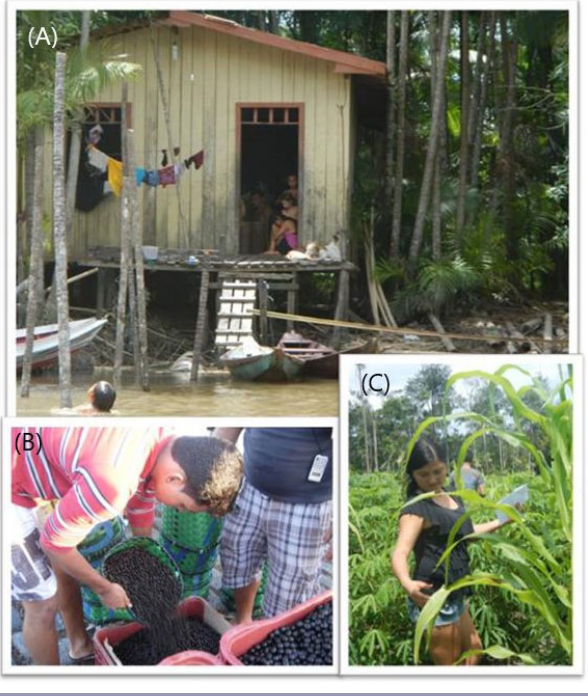
Fig. 1 . Caboclos and their house, açaí, and upland. (a) Caboclos live in wooden houses that are built on the floodplain. The water level fluctuates hourly and the high tides sometimes reach the floor of their houses. The extreme high tides are called lancentes , and have been observed with increasing frequency and duration over the past three decades. Caboclos also manage the forest around their houses intensively. The house garden usually contains açaí trees and some other fruit trees (e.g., lemon, papaya, and banana). (b) Caboclos sell açaí in the market. Açaí was only consumed within the household, but now is a popular commodity and reliable source for family revenue. (c) Caboclos also manage the upland to grow manioc and other crops.